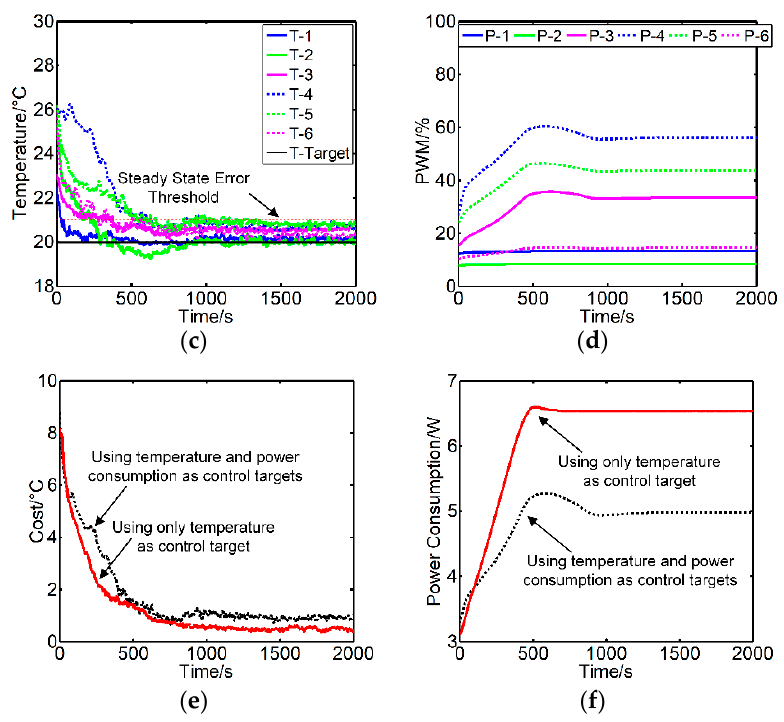
Figure 9. The control effect comparison when using only temperature as control target and using temperature and power consumption as control targets. ( a , b ) Temperature and PWM signals when only considering temperature as the target. ( c , d ) Temperature and PWM signals when considering temperature and power consumption as the targets. ( e , f ) Cost function and power consumption comparison of the two different target settings.